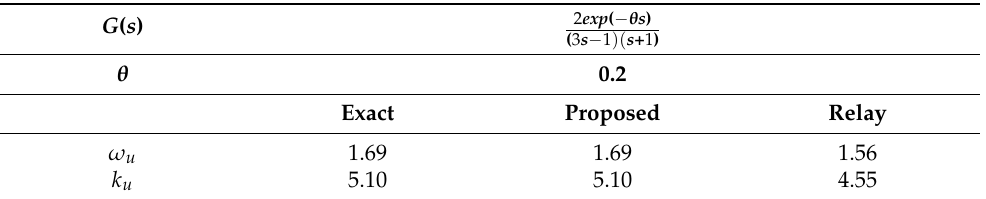
Table 8. Estimates of the proposed method and the relay feedback method [1] for the unstable process and PA set = − π